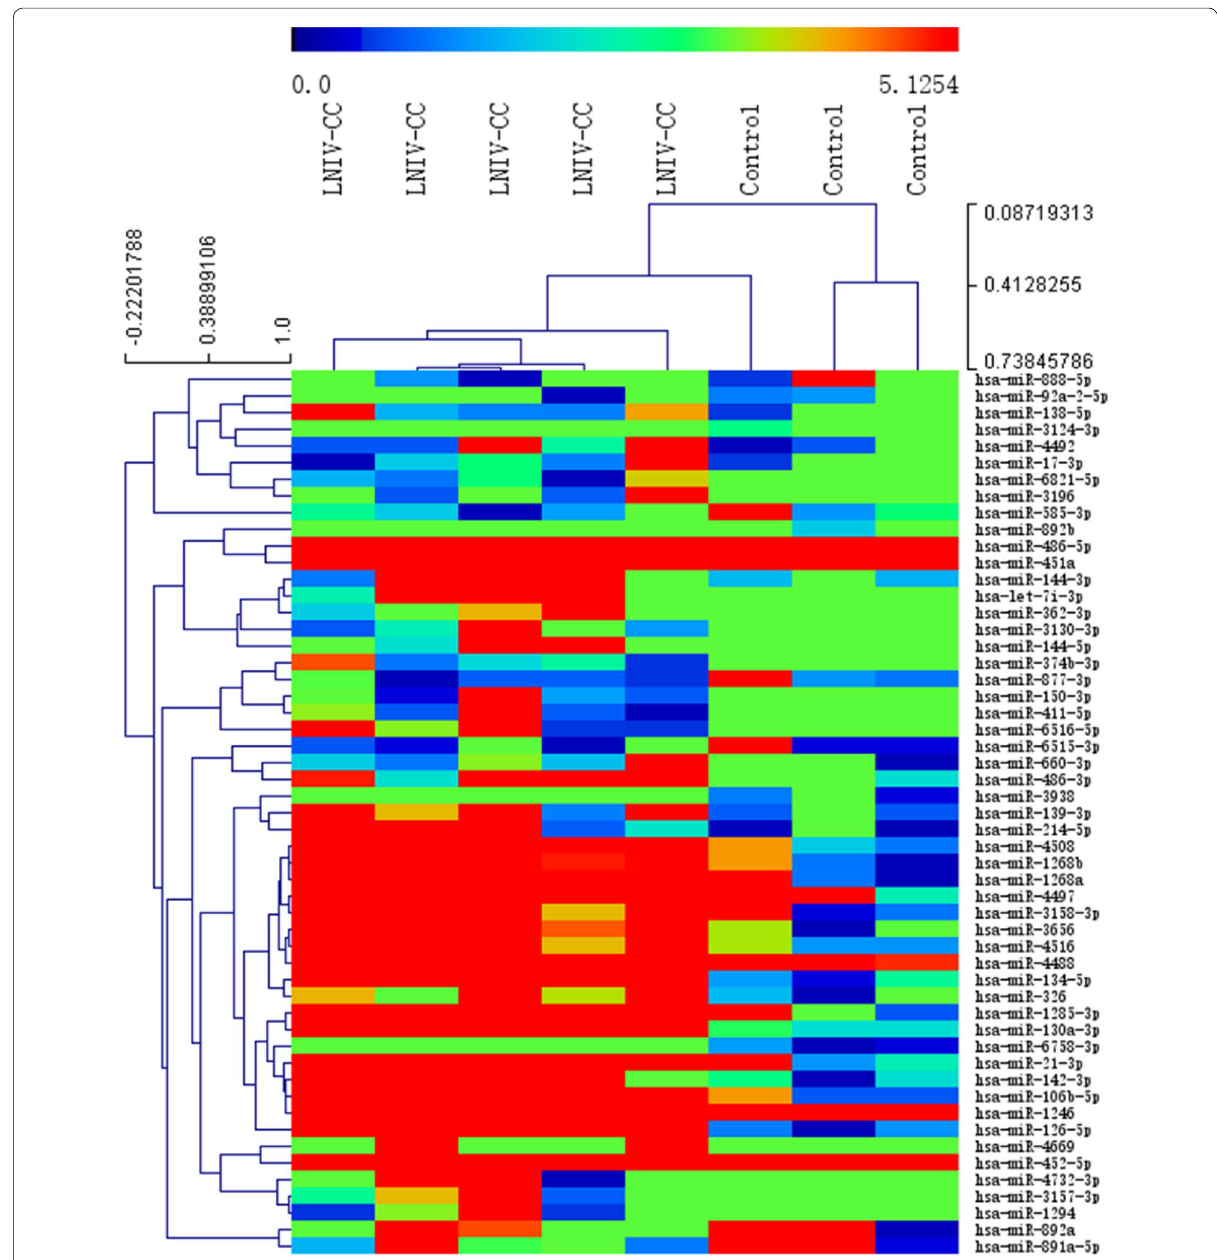
Fig. 2 Heatmaps of differentially expressed miRNAs ( p < 0.05) between LNIV-CC and control